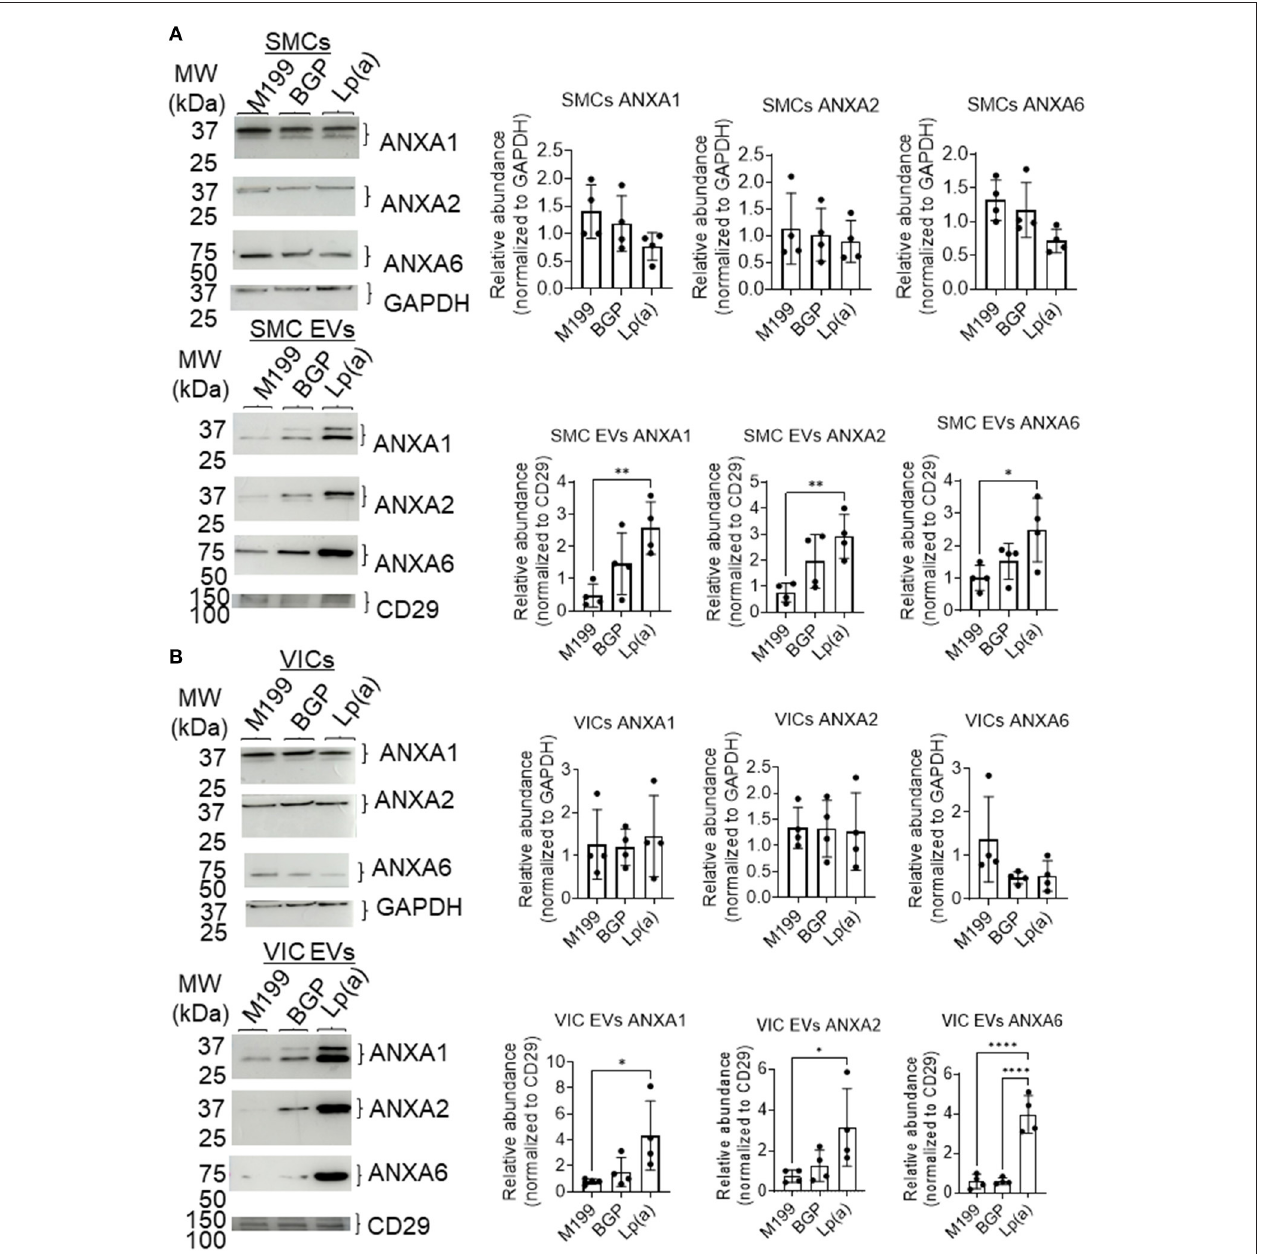
FIGURE 4 | Lp(a) enriched annexins in human SMC and VIC EVs. Western blots with equally loaded (protein abundance) human (A) SMCs total cell lysate and SMC EVs lysate and (B) VICs total cell lysate and VIC EVs lysate for annexins A1 (ANXA1), A2 (ANXA2), and A6 (ANXA6). Example blots shown, with CD29 and GAPDH used as loading controls for quantification; n = 4 donors; analyzed by ANOVA, * P < 0.05, ** < 0.01, **** < 0.0001, error bars = STDEV. Blots were stripped and reprobed for ANXA1, ANXA2 and GAPDH